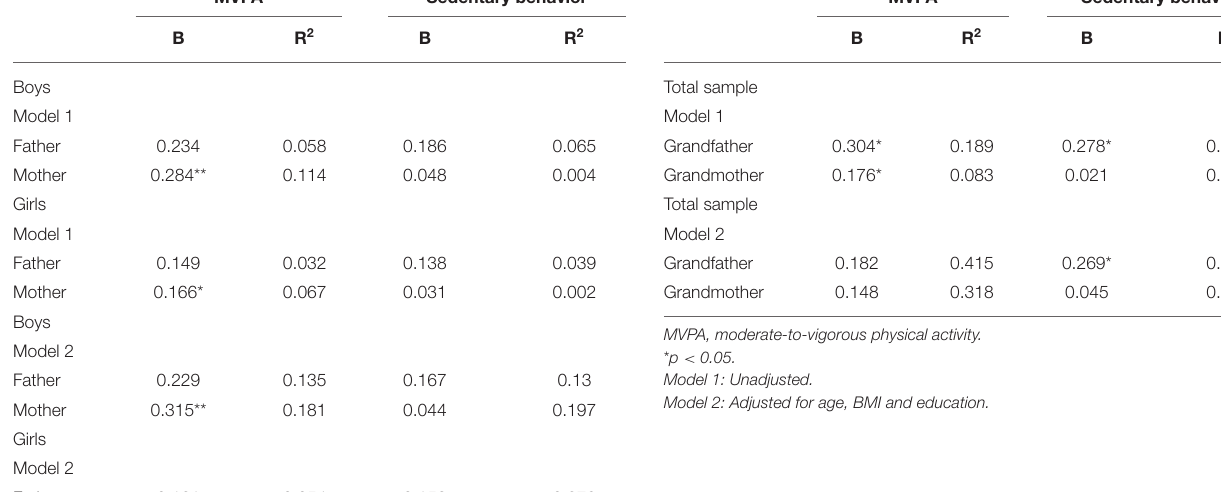
TABLE 4 | Linear regression analysis for variables predicting children’s activity level.